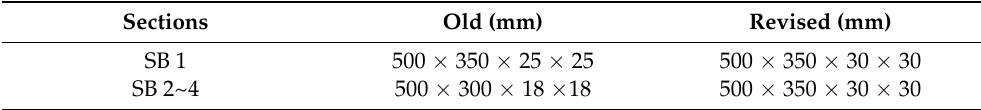
Table A12. Revised Section Members of SB 1 & SB